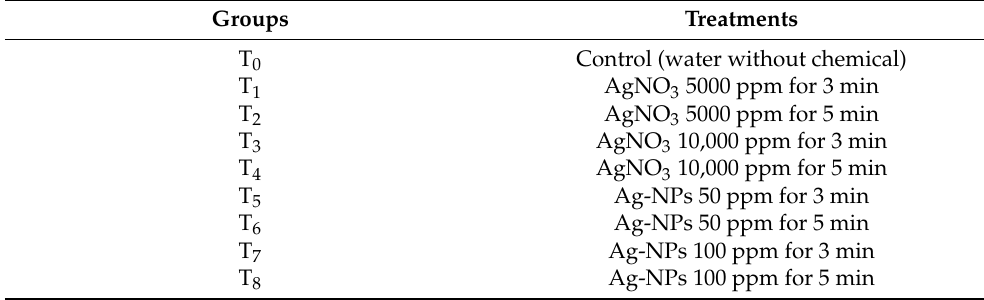
Table 1. Experimental treatments with silver nitrate and silver nanoparticles of different concentra- tions for different periods on Shine Muscat and Kyoho grape. Groups Treatments T 0 Control (water without chemical) T 1 AgNO 3 5000 ppm for 3 min T 2 AgNO 3 5000 ppm for 5 min T 3 AgNO 3 10,000 ppm for 3 min T 4 AgNO 3 10,000 ppm for 5 min T 5 Ag-NPs 50 ppm for 3 min T 6 Ag-NPs 50 ppm for 5 min T 7 Ag-NPs 100 ppm for 3 min T 8 Ag-NPs 100 ppm for 5